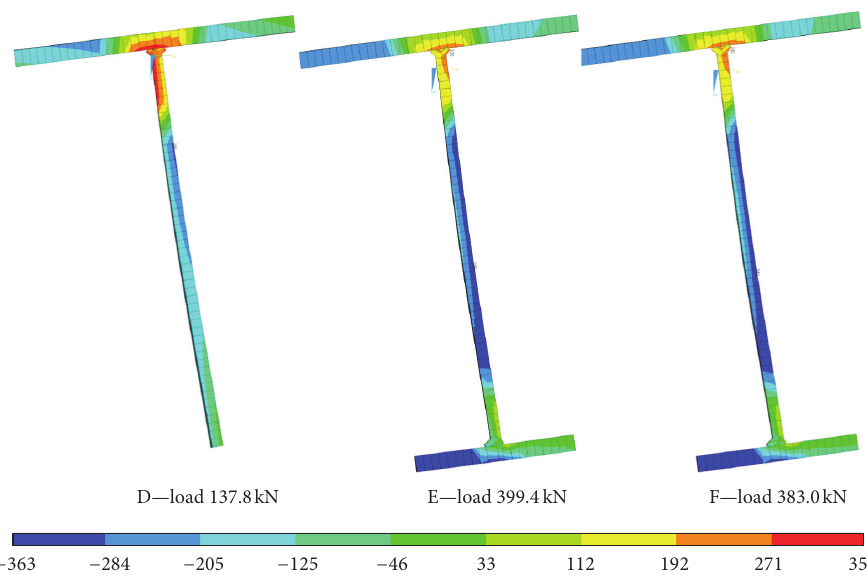
Figure 11: Stresses in the longitudinal direction 𝜎 𝑥 [MPa] at midheight at collapse.